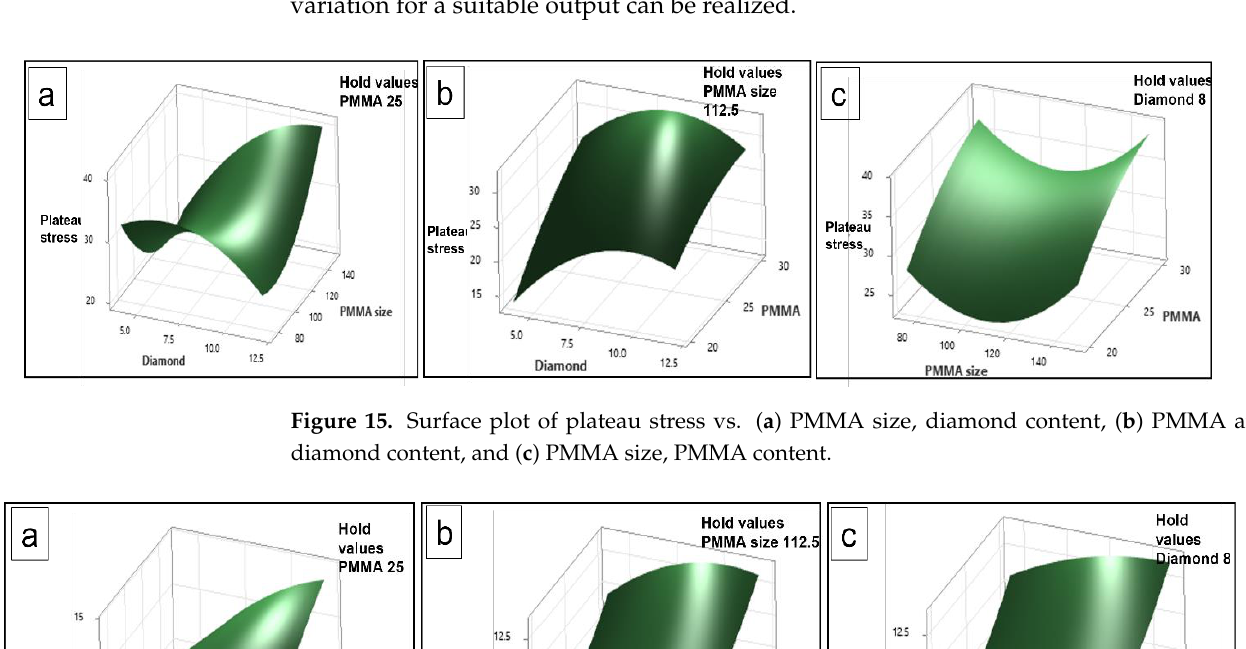
16 of 20 Figure 14. Contour plot of energy absorption capacity of, ( a ) PMMA size vs. diamond content ( b ) PMMA vs. diamond content and ( c ) PMMA size vs. PMMA content. 3.10. Surface Plots Similarly, Figures 15 and 16 show the surface plots comparison for plateau stress and energy absorption capacity as the three-in-one diagram. The results of plateau stress and energy absorption capacity are compared with two factors in each graph, including dia- mond content compared with PMMA size, PMMA content contrasted with diamond con- tent, and PMMA size as opposed to PMMA content, respectively. Furthermore, results were extracted from some of the chosen input combinations for the contours and the max- imum values were found with these data. These surface plots are the three-dimensional